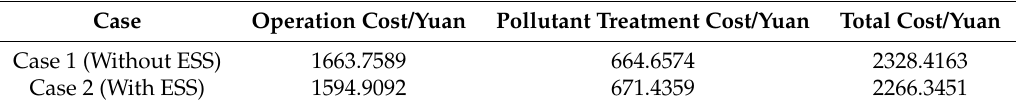
Table 4. Comparison of different